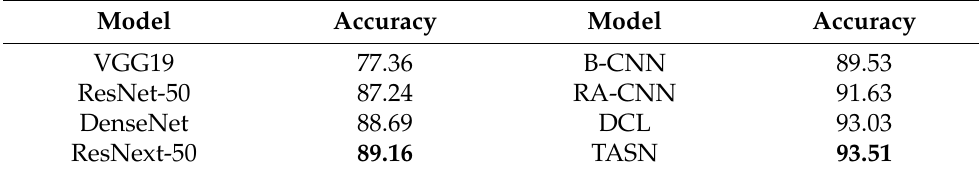
Table 4. Fine-gained classification results of baseline networks. (Top-1 Accuracy).